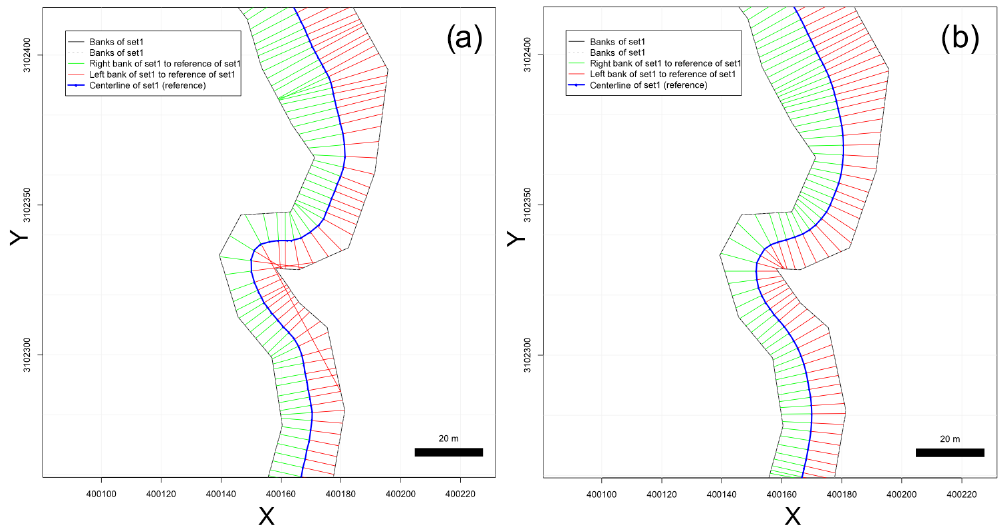
Figure 8. (a) The transects (perpendiculars to the centerline) do not intersect with banks properly, and thus the channel width is overrepre- sented; (b) an increased transect span fixes the problem and channel width is identified